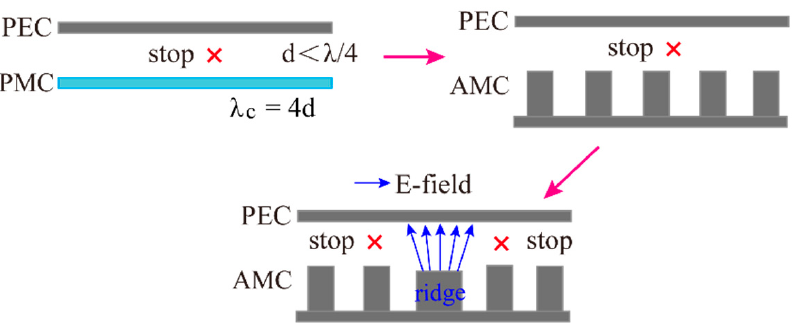
Figure 8. The evolution process of the ridge gap waveguide.